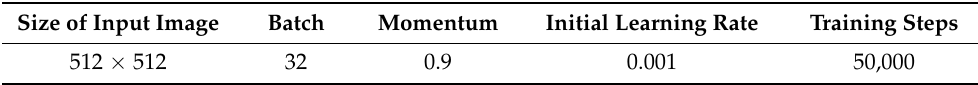
Table 1. Initialization parameters of D-YOLOv3